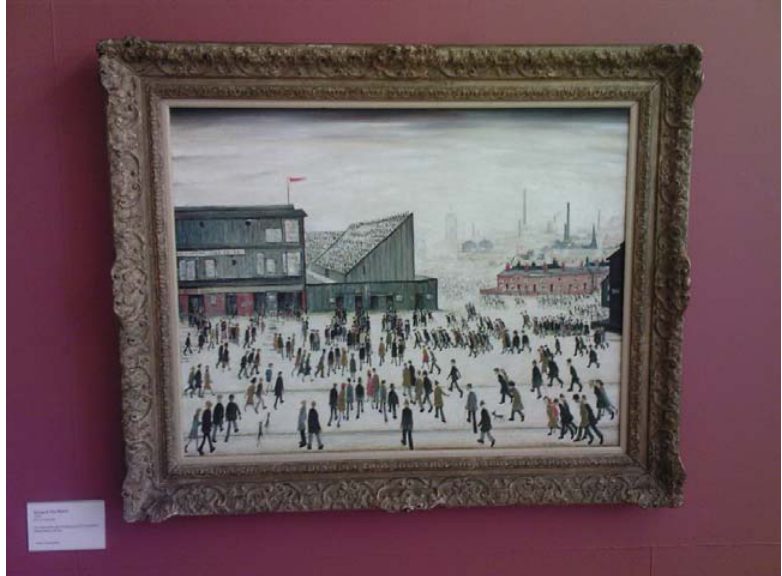
Figure 2. Going to the Match , 1953. Source: